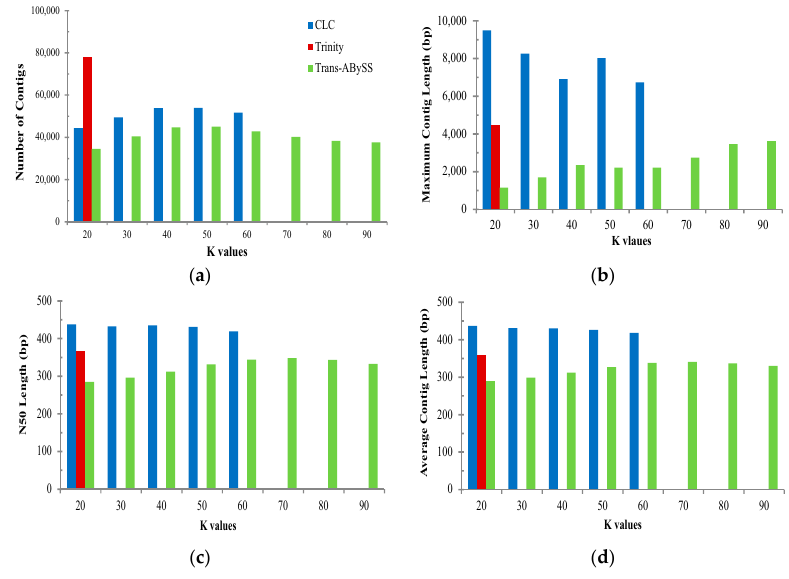
Figure 1. Comparison of de novo assemblies applying multi K -values. K -values in Trinity indicate 25-mer default value. ( a ) Number of cintigs; ( b ) Maximum contig length (bp); ( c ) N50 length (bp), and ( d ) Average contig length (bp). Table 2. Assembly results with best k -mer setting from the M . rosenbergii transcriptome 454 FLX and Ion-Torrent datasets using different de novo assemblers.